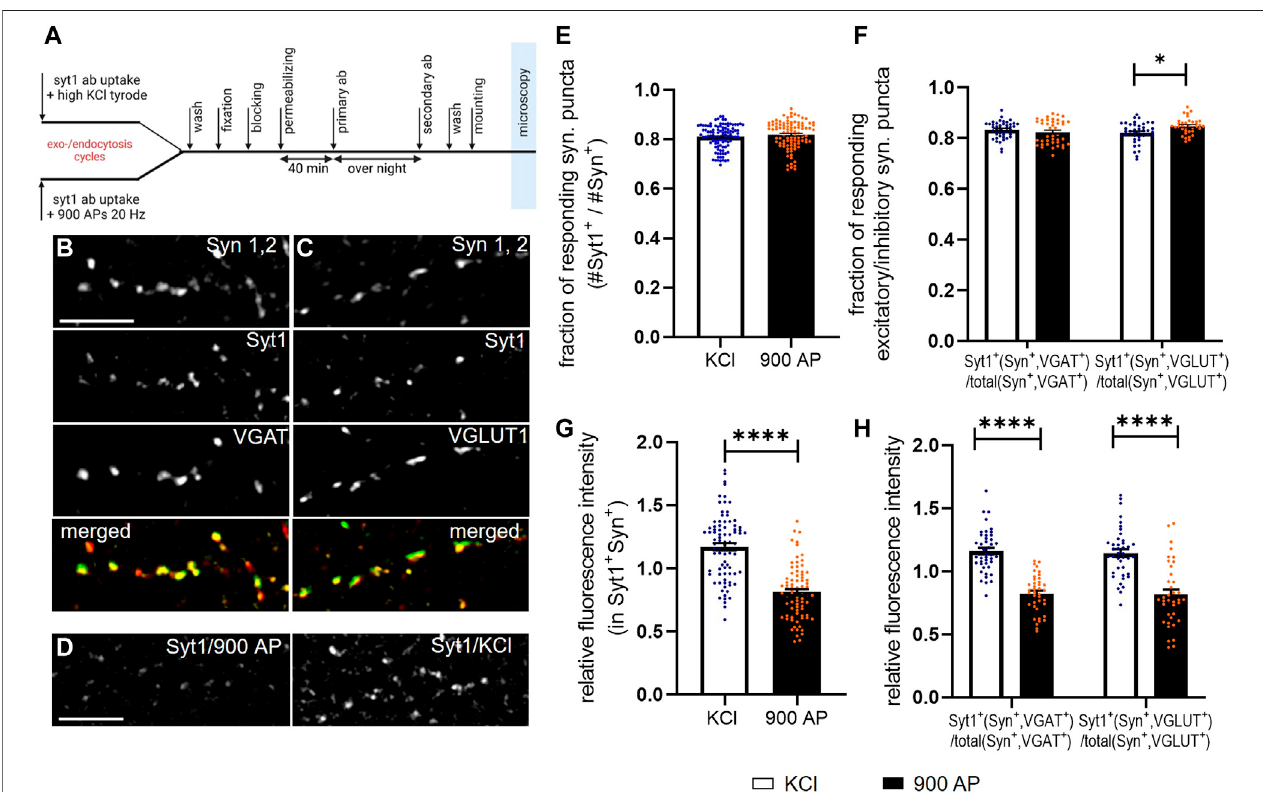
FIGURE 4 | Application of SynEval for the analysis of SV recycling evoked by electrical and chemical stimulation. Experimental design of Syt1Ab uptake with consecutive immunostaining is depicted in (A) . (B – C) The representative pictures are shown for Syn 1,2 staining used to determine synaptic puncta, Syt1Ab uptake assay upon chemical depolarization (50 mM KCl, 4 min) and staining for VGAT for inhibitory synapses (B) and VGLUT1 for excitatory synapses (C) , and respective merged images. (D) Therepresentativeimages ofSyt1uptake uponelectrical stimulation (900AP/20 Hz)andchemicaldepolarization. Scalebars are10 µm. (E,F) Quanti fi cation of active synapses evaluated as fraction of Syt1-positive puncta (Syt1 + ) out of all synapsin-positive puncta (E) or on inhibitory or excitatory synapses de fi ned by VGAT or VGLUT1 staining (F) upon chemical depolarization (KCl) and electrical stimulation (900 AP) stimulation. N was 84 (KCl) or 77 (900 AP) visual fi elds derivedfromeightcoverslipsforeachgroupinEand43(KCl/VGAT),40(900AP/VGAT),40(KCl/VGLUT1),35(900AP/VGLUT1)visual fi eldsderivedfromfourcoverslips per group in F. (G) MFI ofactive (i.e., double positivesSyt + Syn + ) synapses upon chemical depolarization or electrical stimulation. (H) Same analysis as in G but inhibitory (VGAT + )andexcitatory(VGLUT1 + )synapseswereidenti fi edbystainingandevaluatedseparately.NnumbersweresameasinEandF,inthegraphbarsdepictthemean values and whiskers correspond to SEM. Signi fi cance was assessed using Student ’ s t-test, signi fi cance is depicted as **** p < 0.0001, * p <